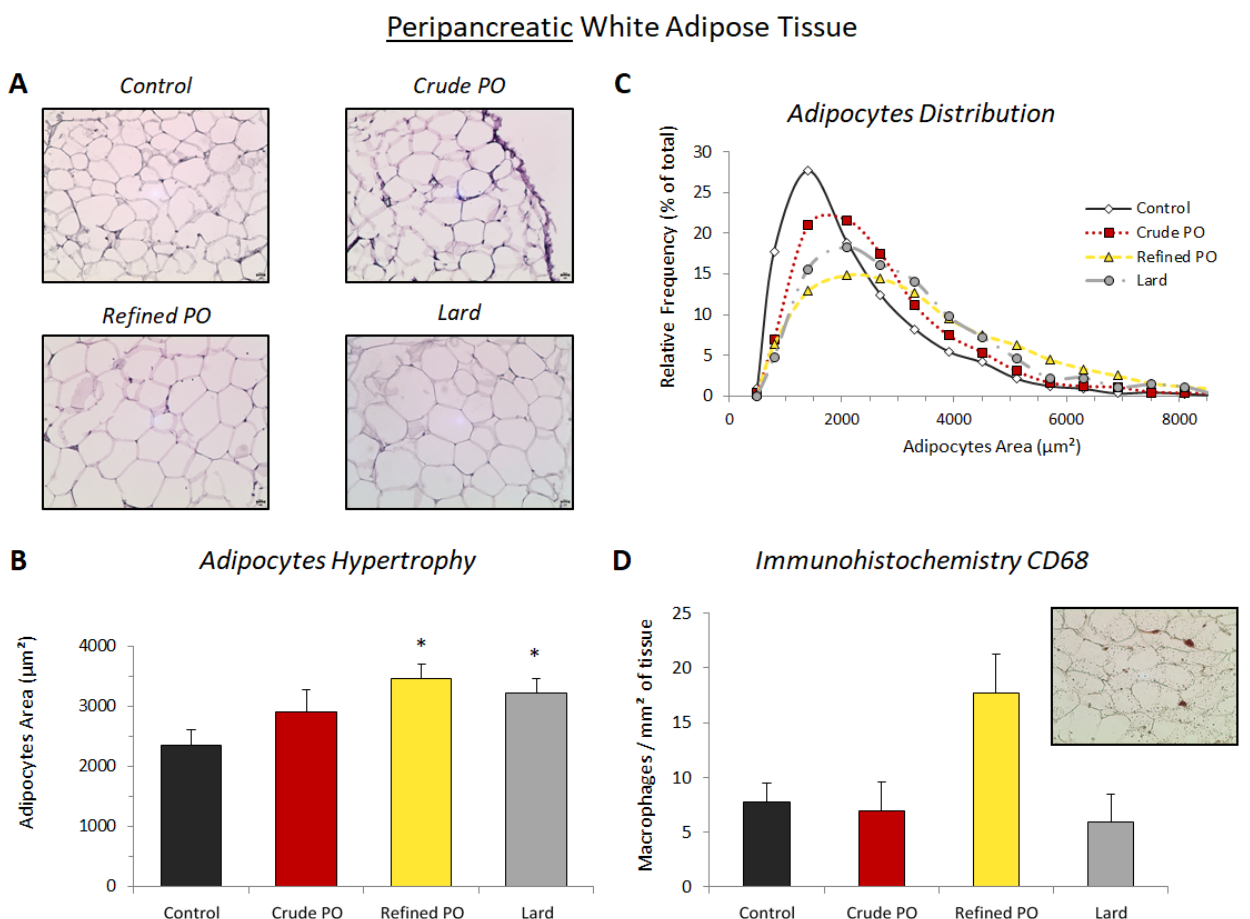
Figure 2. Adipocyte size and macrophage infiltration in peripancreatic adipose tissue (pWAT). ( A ) Representative mi- crophotographs of haematoxylin staining (×200; scale bar = 20µm); ( B ) quantitative analysis of adipocyte area (µm 2 ); ( C ) relative frequency of adipocyte area (%); ( D ) quantitative analysis of immunohistochemistry for CD68 (number of posi- tive cells/mm 2 of adipose tissue). Inset presents an example of CD68 staining in refined PO. Data are shown as means ± SEM, n = 4–7 animals per group. * p < 0.05 vs. control diet.